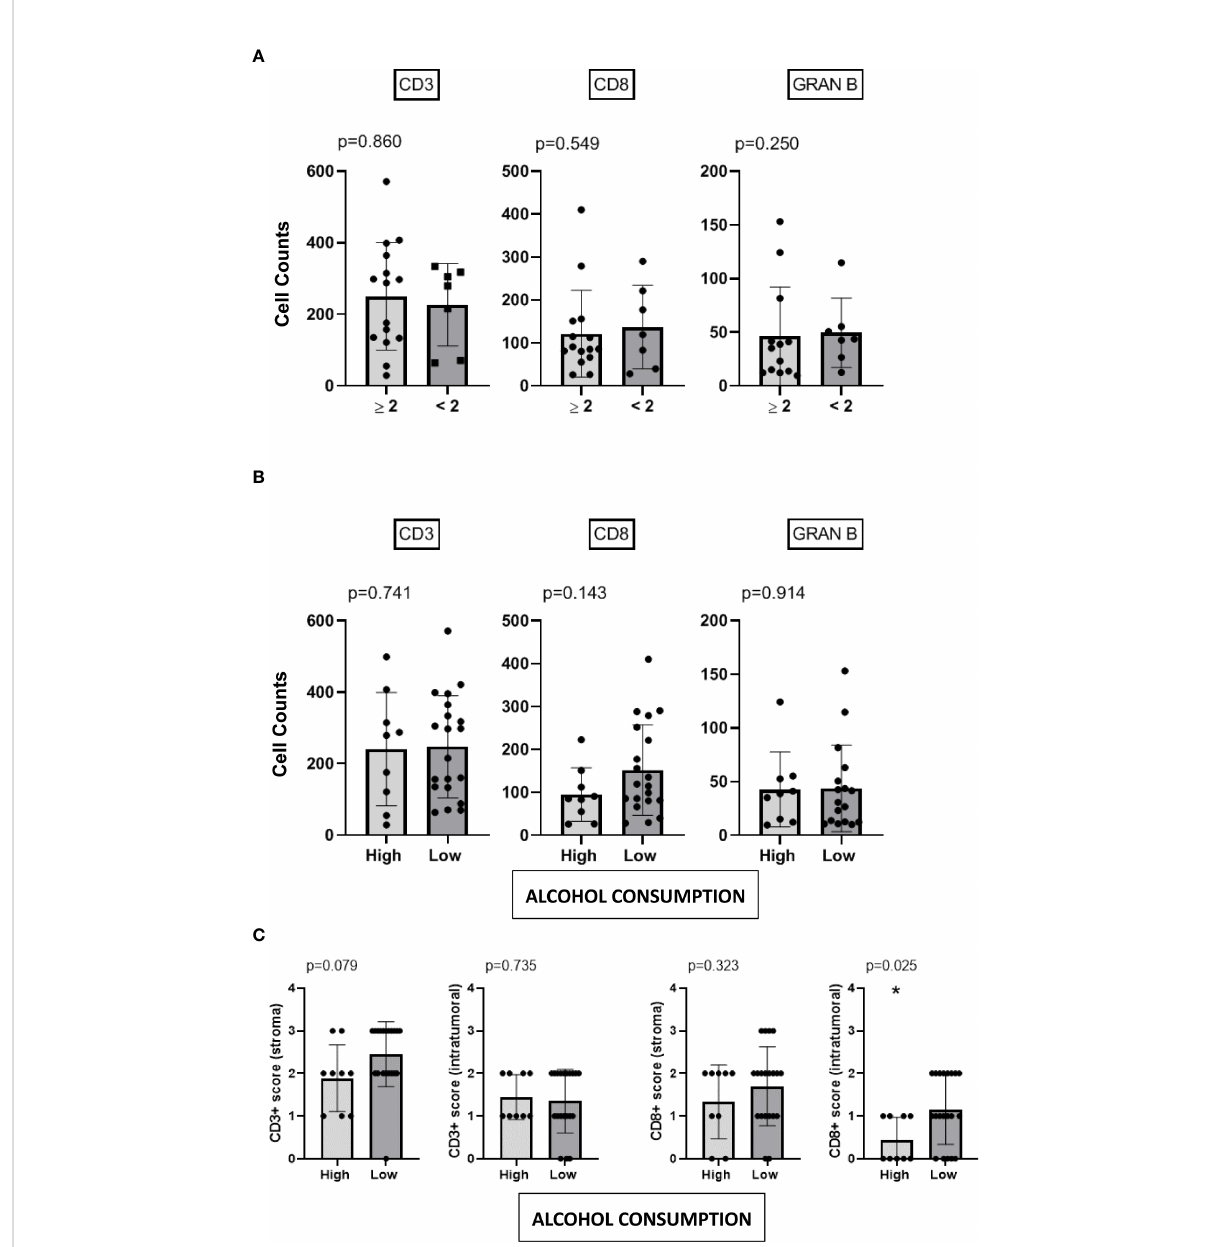
FIGURE 5 Heavy alcohol consumers exhibit a signi fi cant reduction of CD8+ T cells in the tumor center, whereas the total number of CD3+ T cells, CD8+ cells and Granzyme B+ is not altered. Total cell counts of CD3+, CD8+ and Granzyme B (GRANB+) cells (average count from 3 fi elds visualized at 40x) in patients categorized as ≥ 2 or < 2 of TLR9 (A) and high (heavy) or low alcohol consumers (B) . Location of CD3+ and CD8+ cells (at the invasive margin or in the center of the tumor) in the tumor samples expressed according to the scoring system detailed in M&M in patients categorized as high (heavy) or low alcohol consumers (C) . *p < 0.05 was considered statistically signi fi